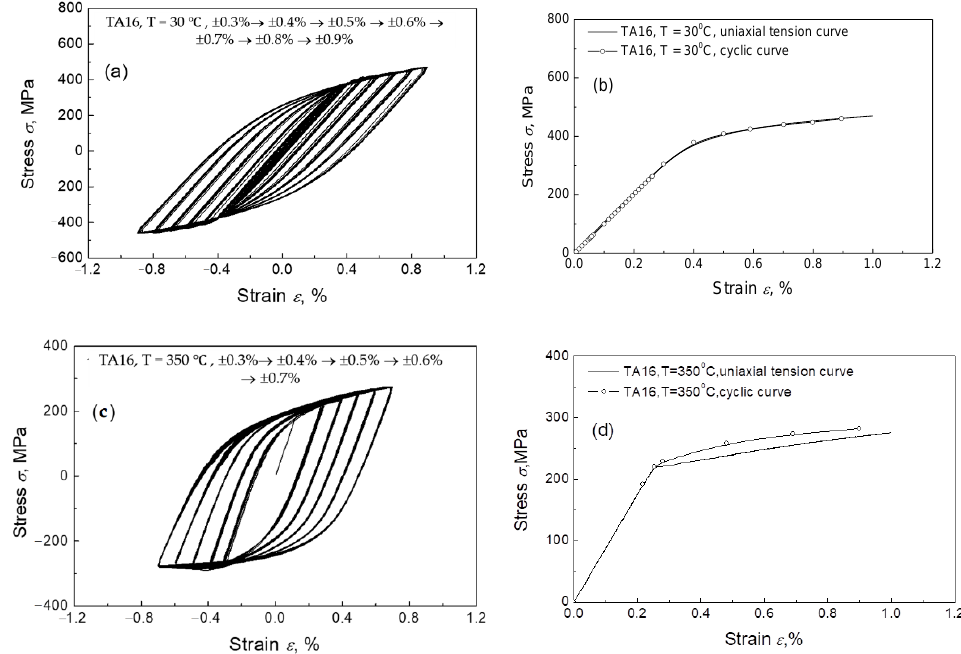
Figure 12. Experimental results under strain control: ( a ) cyclic stress-strain curve at room temperature; ( b ) stable cyclic curve and uniaxial tensile curve at room temperature; ( c ) cyclic stress-strain curves at 350 °C; ( d ) stable cyclic curve and uniaxial tensile curve at 350 °C.